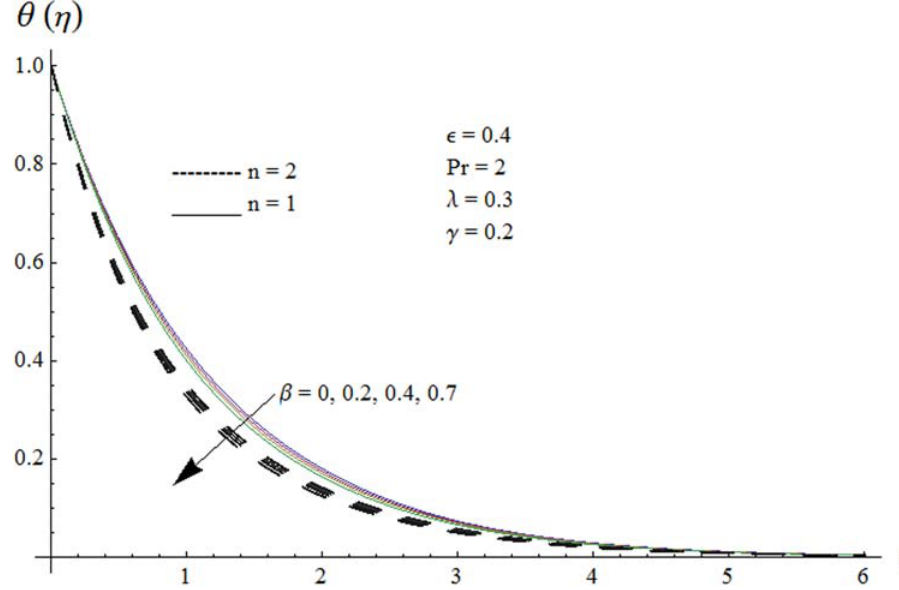
Fig 9. Effect of β on temperature profile.